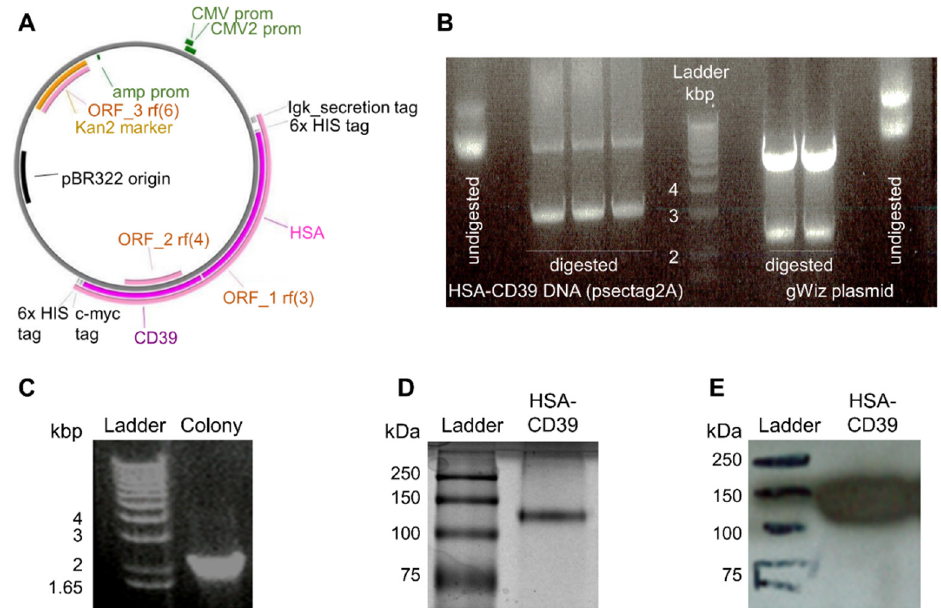
Figure 1. Vector map, generation, purification and characterisation of the HSA-CD39 construct. ( A ) Gene map of the HSA-CD39 construct (8585 bp) within the gWiz vector. The restriction enzymes for inserting the construct are EcoR1-HF and PsPOMI. ( B ) HSA-CD39 cut from pSectag2A (3235 bp) and ligated into gWiz by 1% agarose electrophoresis gel, double digested using EcoR1-HF and PsPOMI. ( C ) Control PCR on 1% agarose electrophoresis gel using gWiz forward primer and Not-1 reverse primer to detect HSA in gWiz (2149 bp). ( D ) Visualized via Coomassie staining, 12% sodium dodecyl sulfate–polyacrylamide gel electrophoresis of the HSA-CD39 construct. ( E ) Western blot analysis using a horseradish- peroxidase–coupled anti-6x-his to detect the 6x-his-tag of the HSA–CD39 construct (141 kDa).